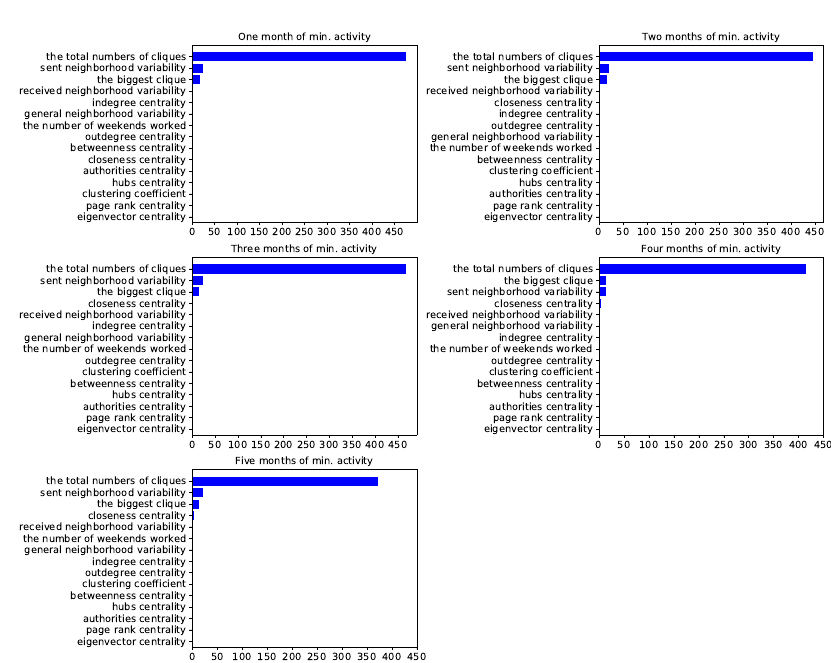
Figure A11. Features importance (based on univariate feature selection method which uses chi-squared test) for the Neural Network and SVM which use the full set of features for the Enron dataset with two levels of the hierarchy.